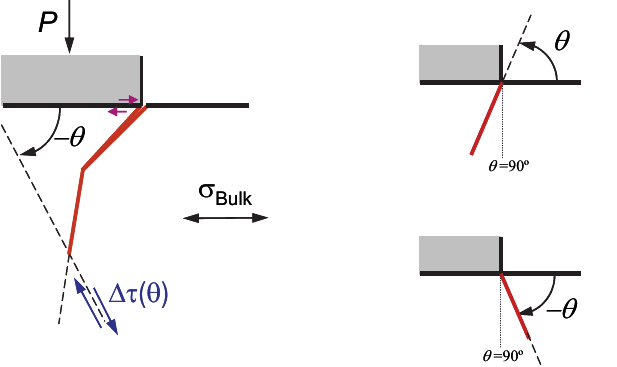
Figure 2: Application of the min (  ) criterion to predict the third crack-growth increment direction. Sign convention for direction angles of a crack growth